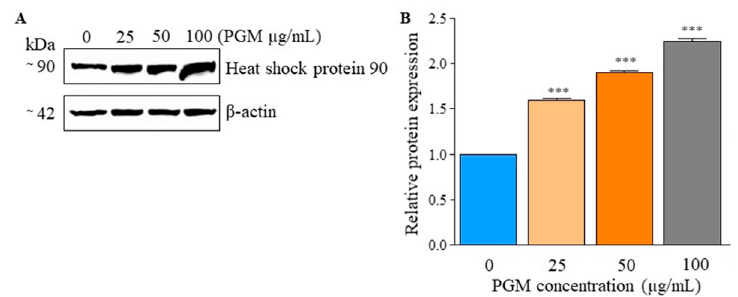
Figure 6. Expression of Hsp90 in PGM-exposed zebrafish larvae by immunoblot analysis. ( A ) Expression levels of Hsp90 in PGM-exposed (0, 25, 50, and 100 µg/mL) larvae are shown ( B ) Quantitative analysis of Hsp90 expression in larvae is displayed with β -actin expression, relative to the untreated control. The asterisk marks are used to indicate statistical significance compared to the control (one-way ANOVA, *** P < 0.001).